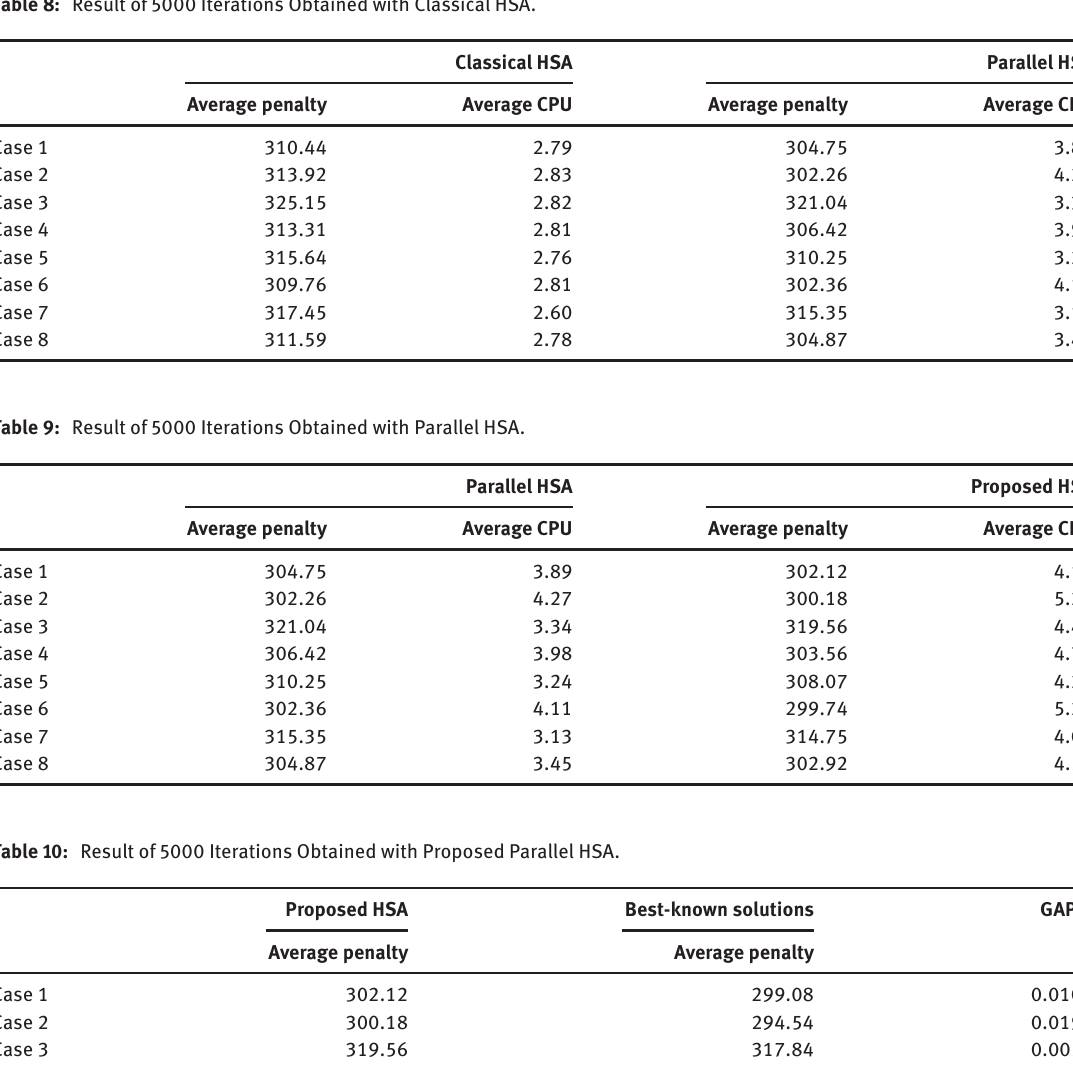
Table 8: Result of 5000 Iterations Obtained with Classical HSA.